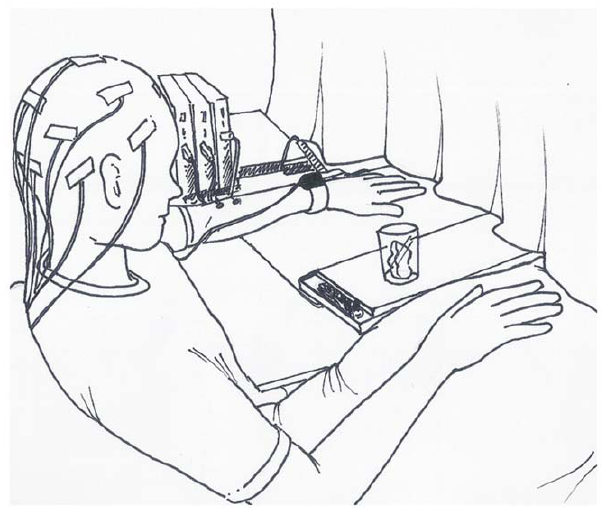
Figure 2. The participant sat with his left arm placed over a table. The right arm rested over a pillow for the duration of the session. An experimenter sat behind a black curtain and presented each cylinder fitted in a socket. Upon presentation, participants were instructed to wait, grasp the cylinder with the left hand and bring it close to the chest. Subjects were then asked to put the cylinder down on the tray socket and return the hand to the initial position. EEG and EMG signals were recorded throughout the